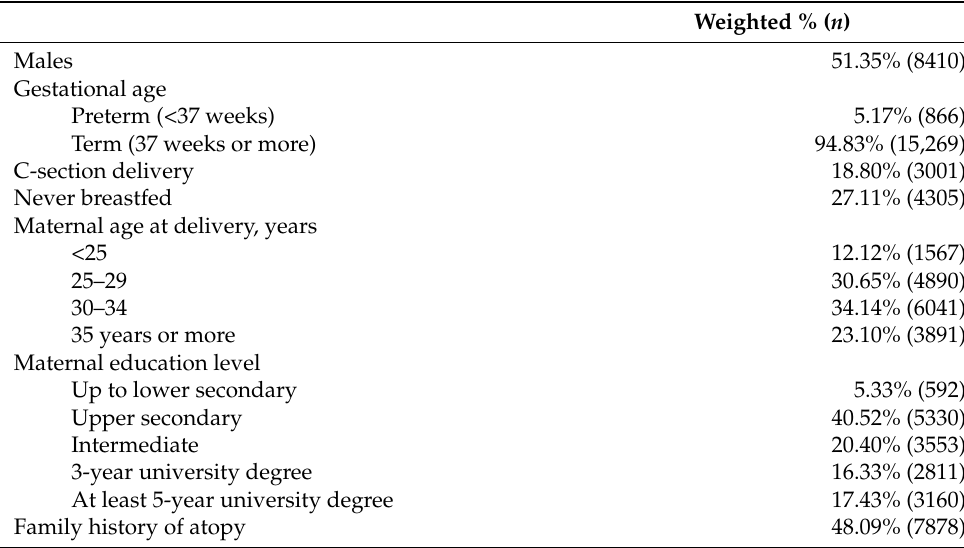
Table 2. Sample characteristics ( n * = 16,400).